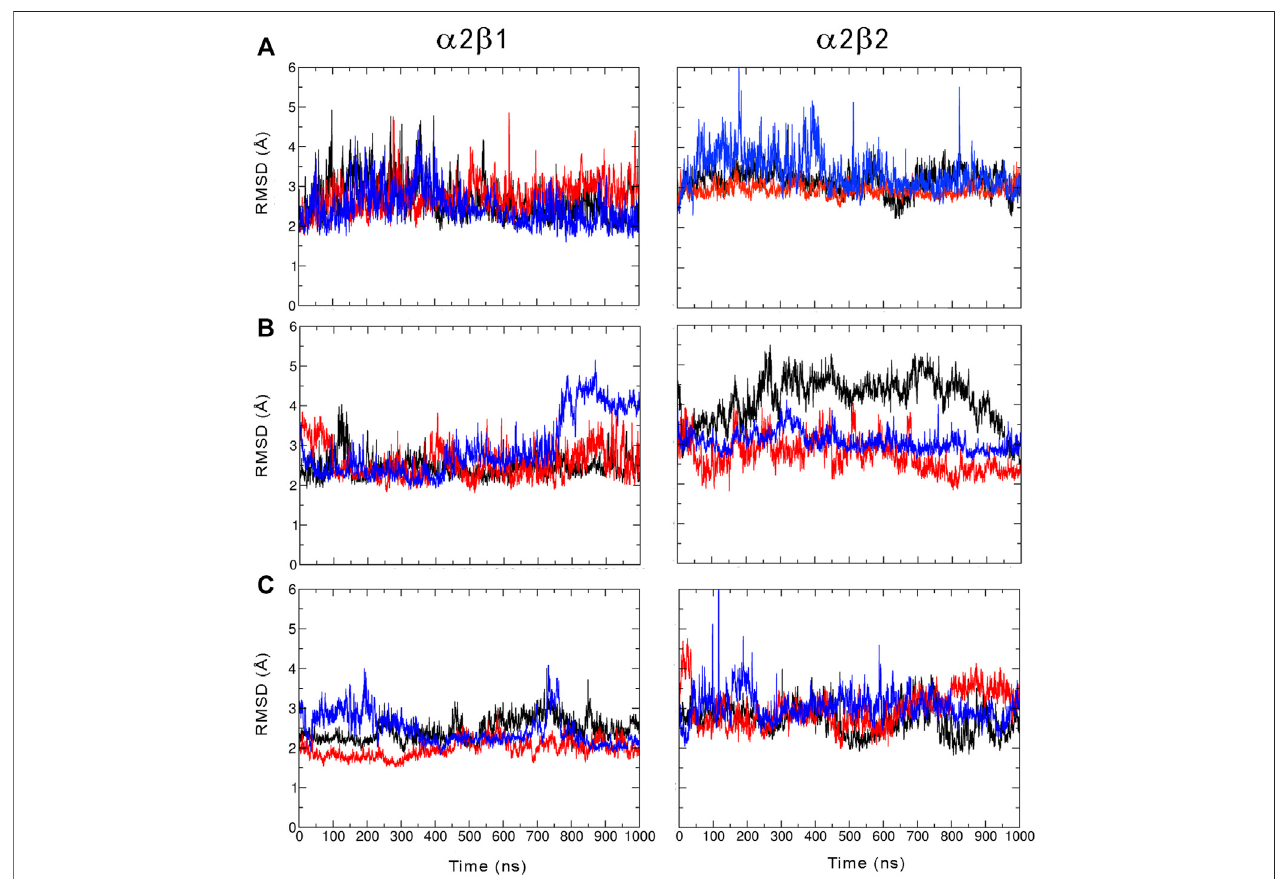
FIGURE2| Rootmeansquareddeviation(RMSD,Å)determined fortheproteinbackbonealongthethree1 µsMDsimulationsrunforthe (A) apo, (B) holoand (C) holo+ATP species of AMPK isoforms α 2 β 1 and α 2 β 2 bound to PF-739 (each replica is shown in black, blue and red, respectively). For each analysis the reference structure used corresponds to the energy-minimized average structure of the holo+ATP sampled in the last 200 ns of the three independent MD simulations.